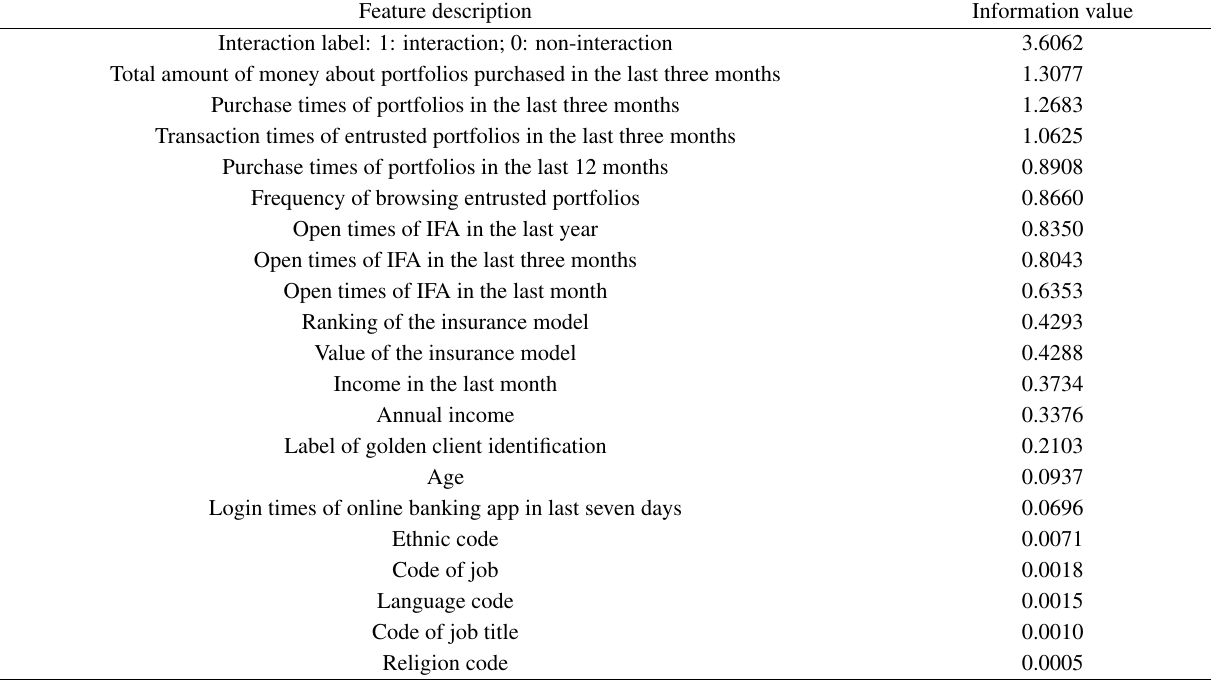
Table 2 Description and information value for user